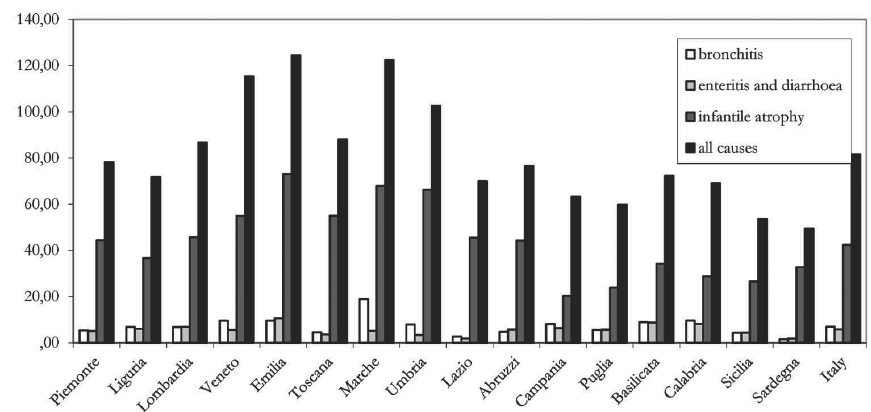
Figure 5 – Neonatal mortality rates (per 1,000) for some causes of death in Italy and in the regions